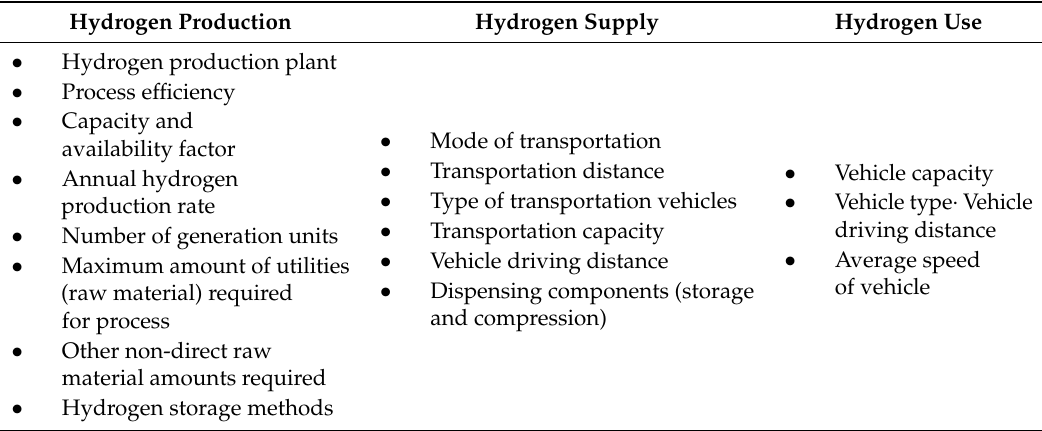
Table 3. Economic analysis equations used for life cycle analysis. Equation Number